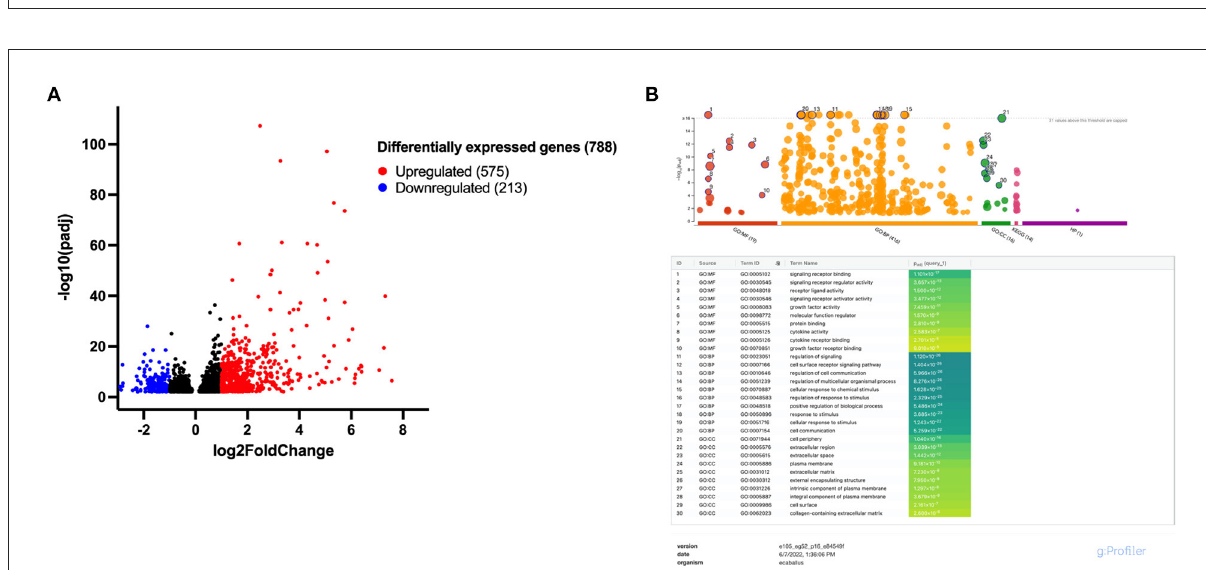
FIGURE3 Approximately 788 differentially expressed genes (DEGs) were identified following IL-1 β licensing of equine MSCs with overrepresented terms including growth factor and cytokine activity and extracellular matrix-associated functions. (A) Volcano plot for differential expression analysis depicting the log 2 fold change and -log 10 (adjusted p value) for gene transcripts in IL-1 β licensed MSCs detected by RNA-sequencing. Significantly upregulated DEGs are presented in red and significantly downregulated DEGs in blue with absolute fold change > 1.0 and a p